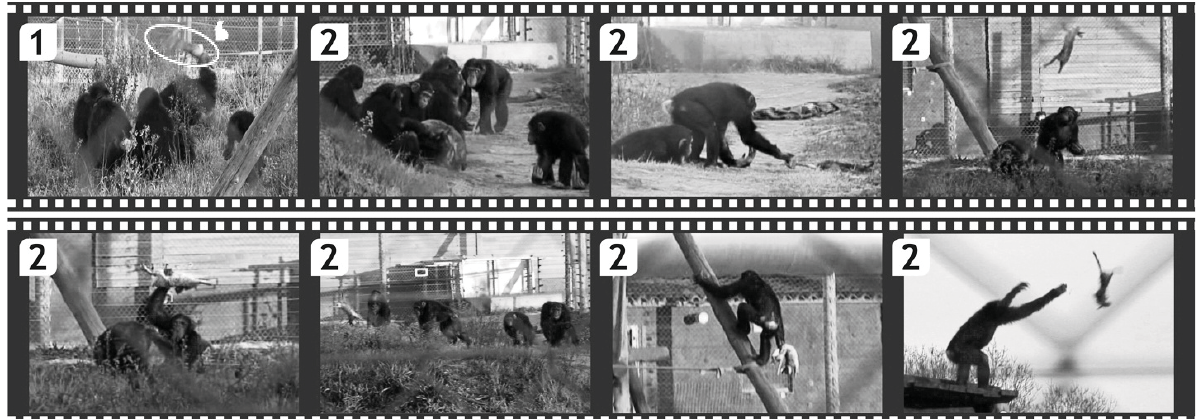
Figure 2. ( 1 ) Slaughter : Toto holds the rabbit by its hind legs and beats it to death against the ground. ( 2 ) Exploration : Toto discards the rabbit and juvenile and young chimpanzees start exploration and play